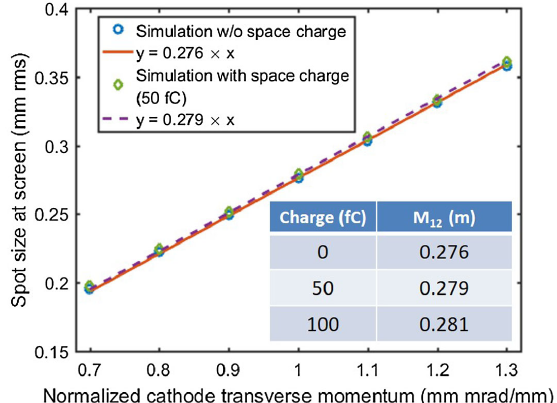
FIG. 3. The beam size at the observation screen is linearly proportional to the cathode transverse momentum in simulation with and without space charge. The fit formula is presented in the legend. Here the solenoid has been set to meet the imaging condition.